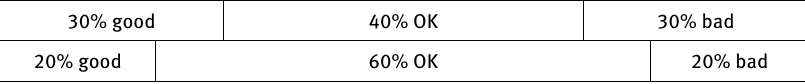
Fig. 2: Good and bad Dutch sailors both exceed international